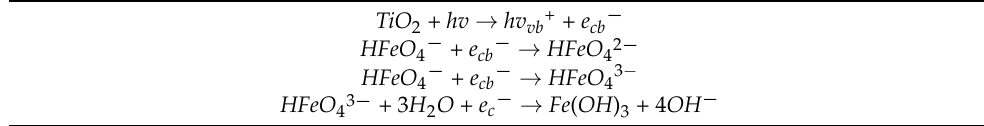
Table 6. The mechanism of electron transferring and formation of derived ferrate species in UV/Fe(VI) system [28,29].